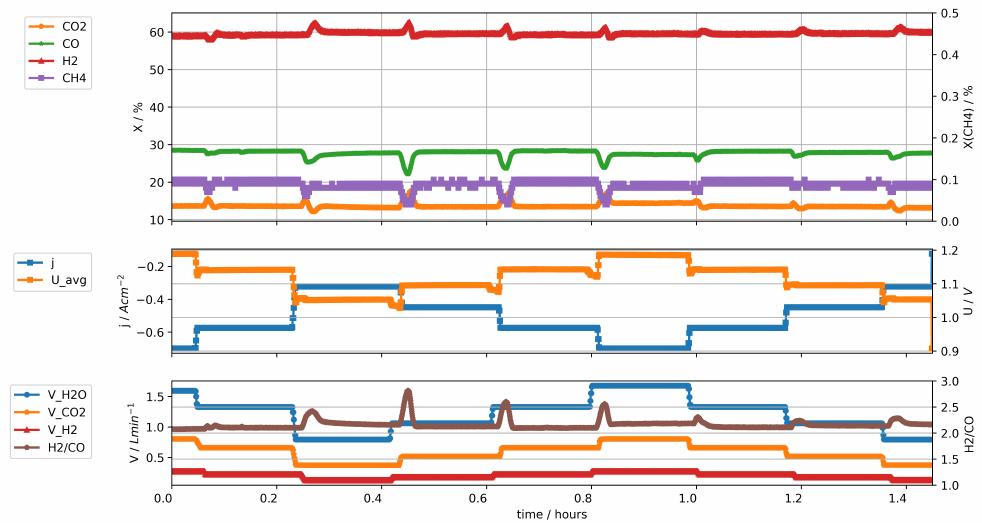
Figure 8. Gas analysis during dynamic load cycles (top), current density and voltages (center), feed gas flows and measured H 2 /CO ratio